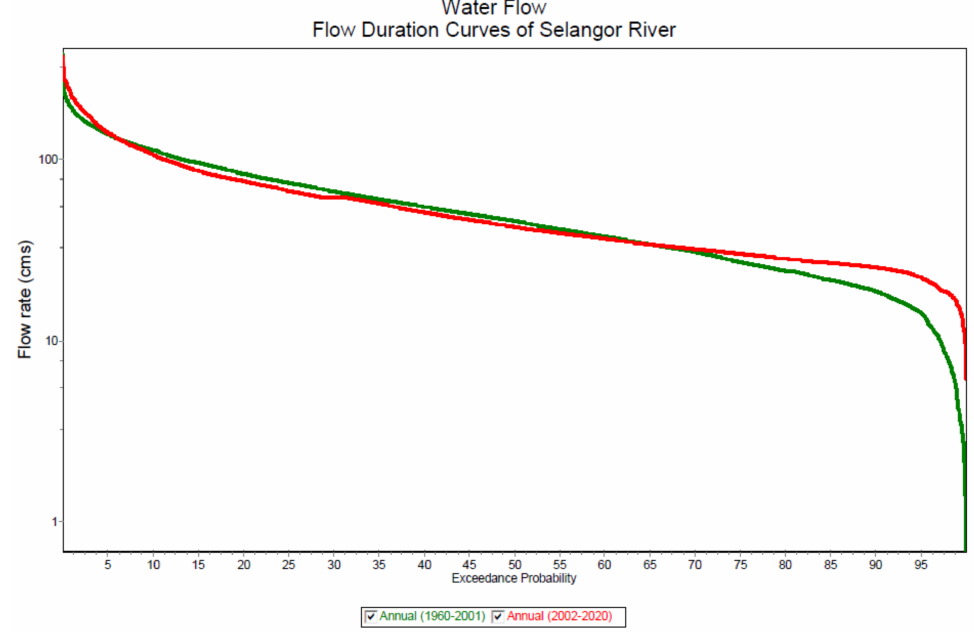
Figure 7. IHA analyzed Annual Flow Duration Curves of pre- and